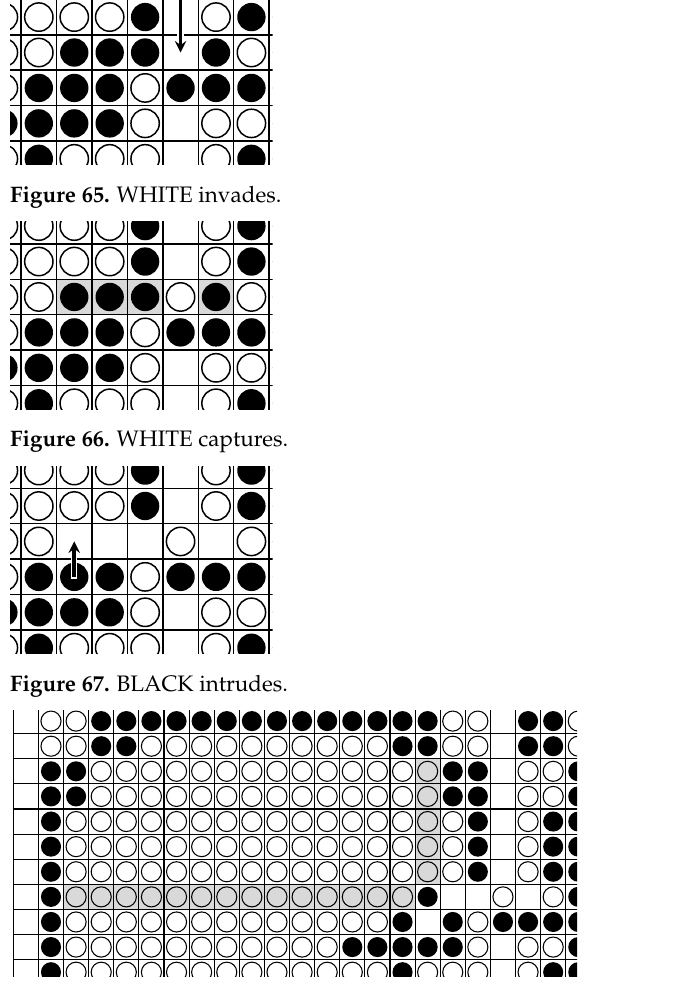
Figure 68. BLACK wins.